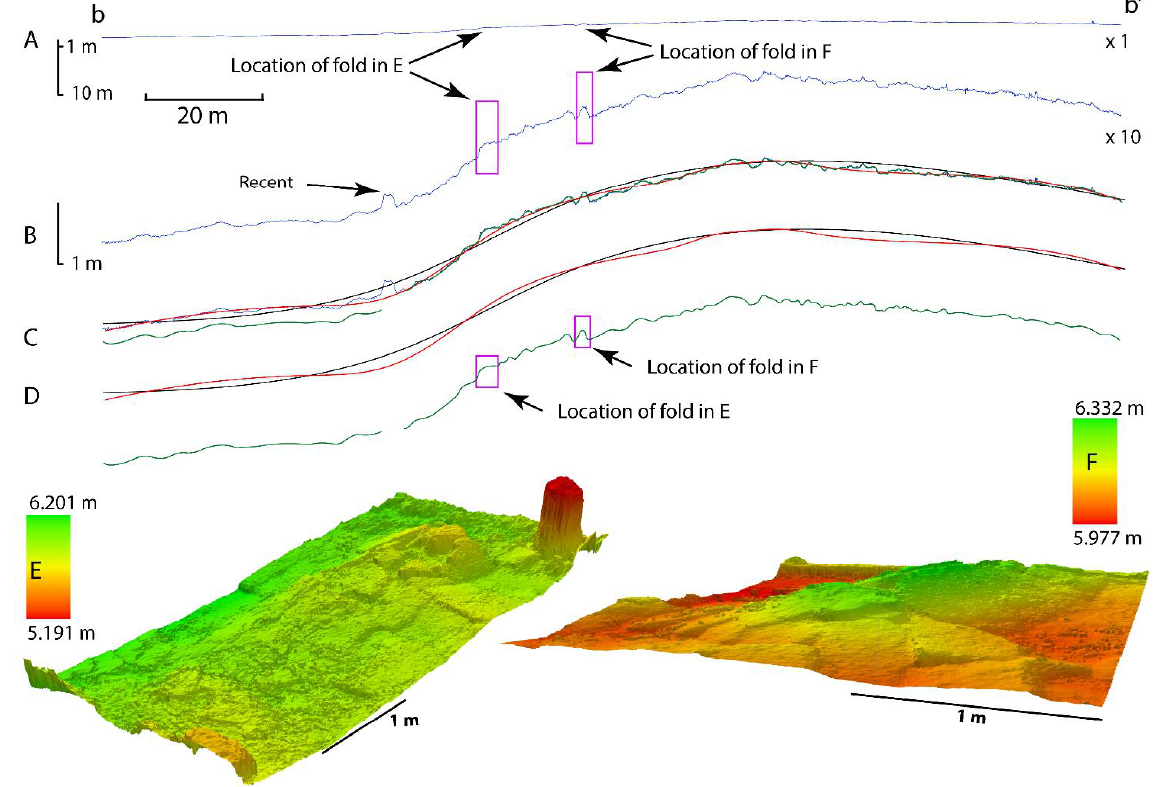
Figure 10. ( A ) Topographic profile obtained from a 3 mm pixel DEM obtained from drone photogrammetry, from b to b’ (see Figure 9 for location) and without vertical exaggeration. ( B ) Same topographic profile, from b to b’, with ×10 vertical exaggeration. ( C ) Superimposed mapped fold geometry from the exaggerated topographic profile showing different amplitude and wavelengths from several tens of m (black) to a couple of tens of m (red) to individual metric folds (green). ( D ) Disaggregated fold geometry, with the comparison of the larger folds (black and red, up) and individualized minor folding (green, down). ( E ) Example of the smaller folds with centimetric amplitude and metric wavelength; those folds were probably constrained by the dimension of the slabs of the paving; see location in D, A and Figure 9. ( F ) Example of the smaller folds with centimetric amplitude and metric wavelength; note the periclinal termination of the fold at both extremes of the structure and the amplitude of some 35 cm; these structures were identified and previously mapped in Silva et al. [14].